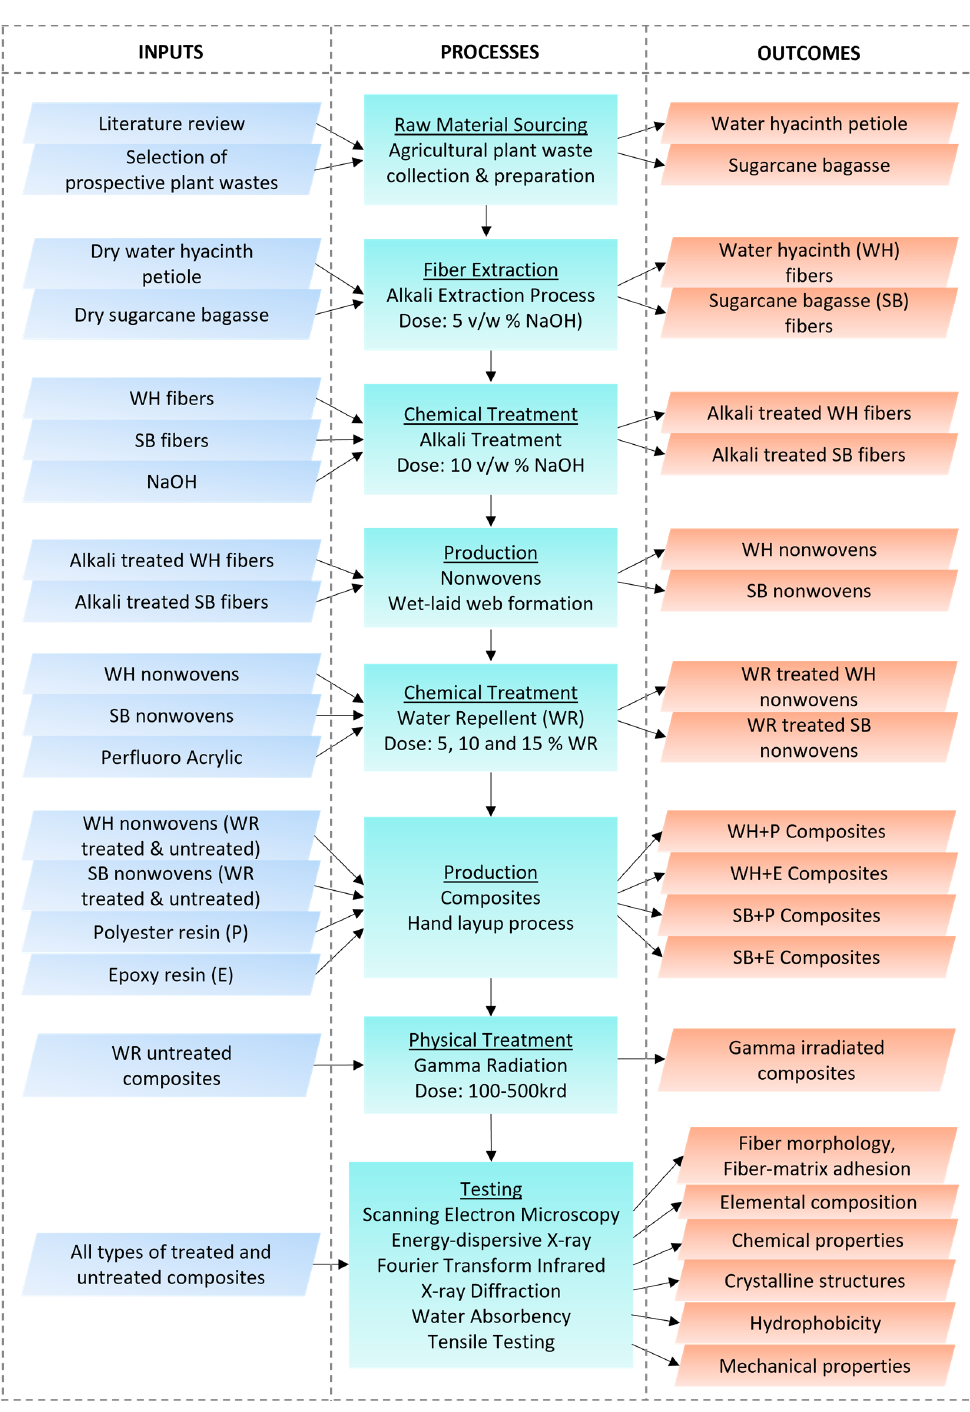
Figure 1. Experimental process